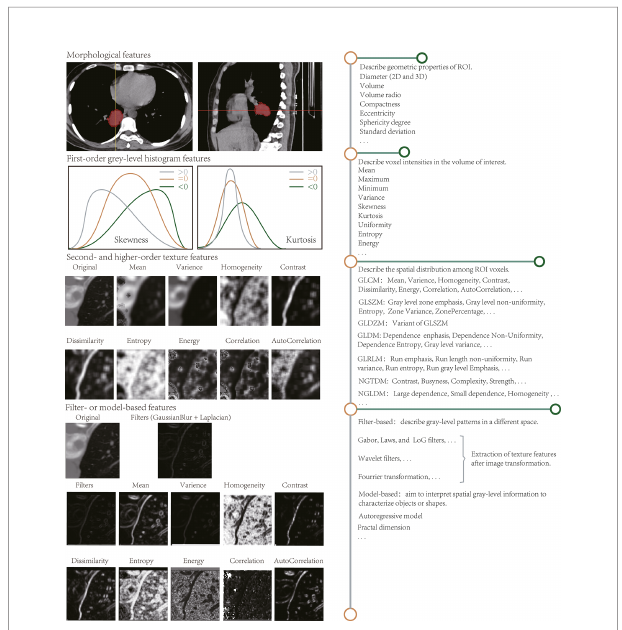
FIGURE 1 | Radiomic features extracted by radiomic analysis tools. The length of the horizontal line on the right describes the approximate number of